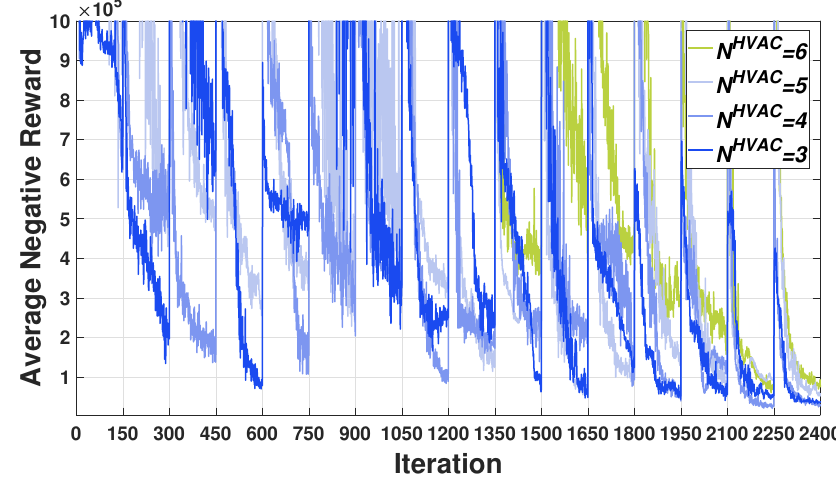
Figure 11. Average negative reward convergence with different number of HVAC agents ( N HVAC